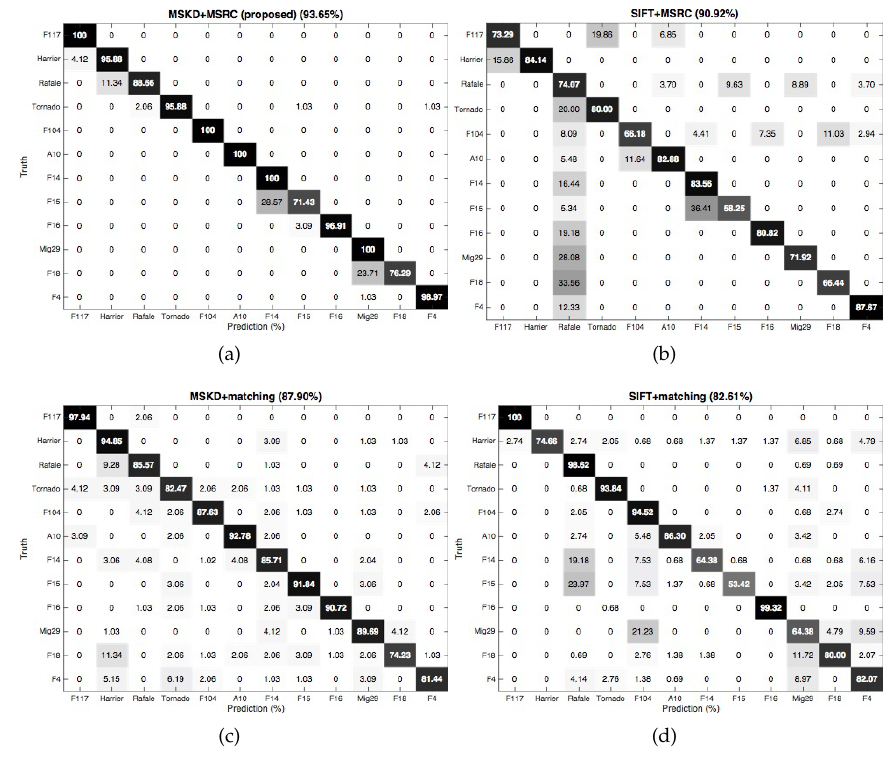
Figure 6. Confusion matrix of the different methods on ISAR images database: ( a ) MSKD + MSRC; ( b ) SIFT + MSRC; ( c ) MSKD + matching; ( d ) SIFT + matching.